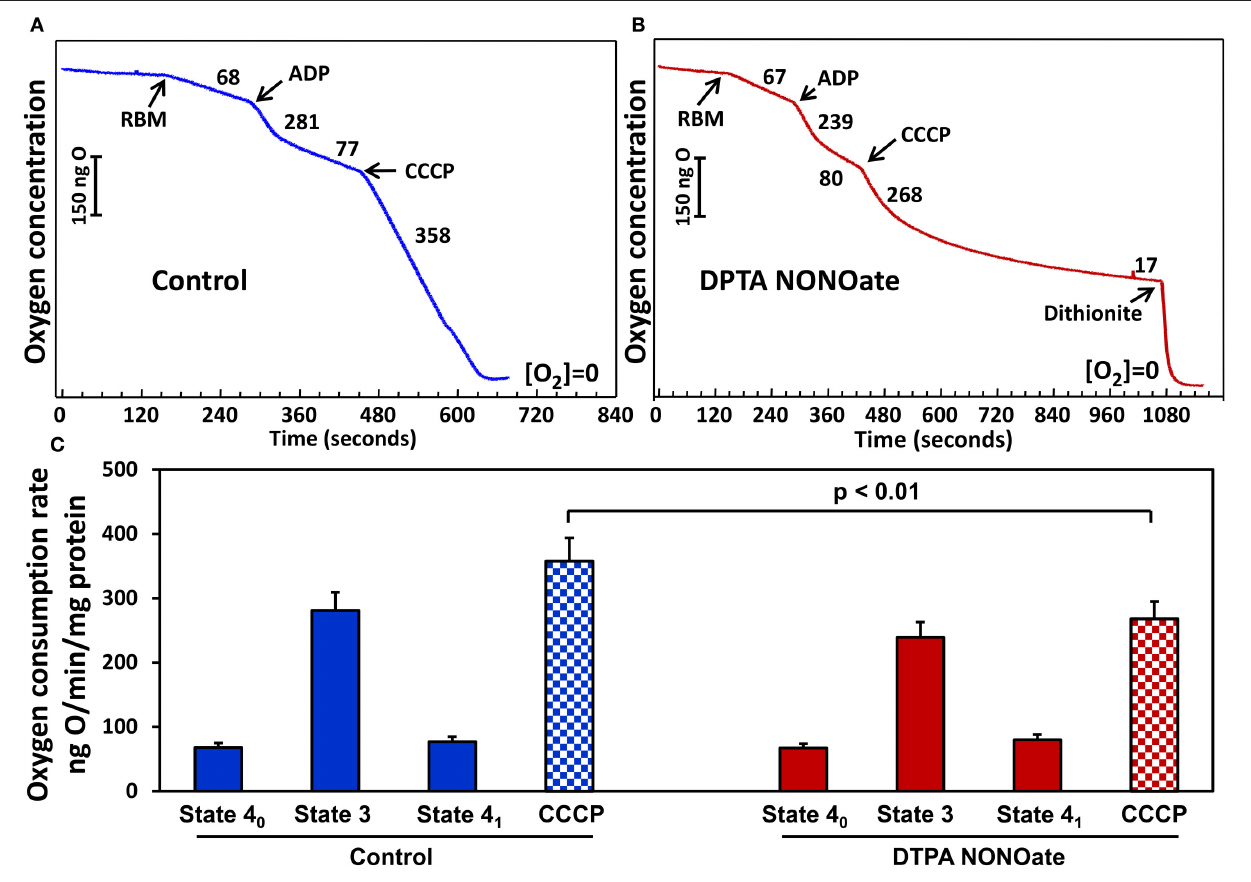
FIGURE 3 | Effect of nitric oxide on respiration with glutamate/malate by rat brain mitochondria (RBM) (A) . Mitochondria (0.5 mg/ml) were supplemented with slow releasing NO-donor DPTA NONOate (100 µ M) (B) . (C) Oxygen consumption rate is expressed as ng O 2 /min/mg protein. Clark oxygen electrode was calibrated with air saturated water at 25 ◦ C. Instrumental zero oxygen level ([O 2 ] = 0) was confirmed at the end of every experiment by addition of sodium dithionite as shown in (B) . State 4 0 , State 3 and State 4 1 were defined as previously described in Panov (2014). Results represent mean ± SEM ( n = 4). * P < 0.01 vs.